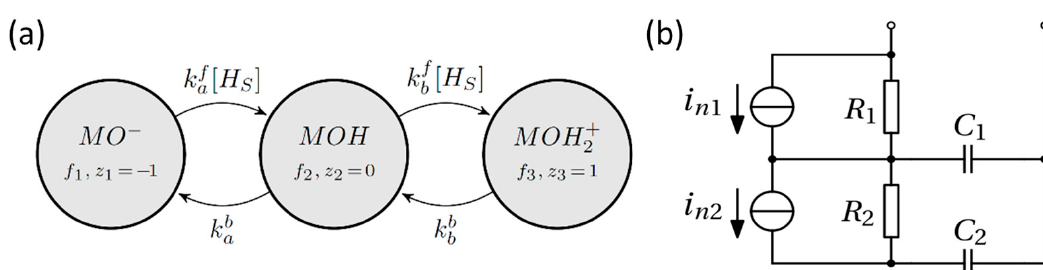
Figure 6. ( a ) Kinetic diagram of the site binding (SB) model from Reference [20]. The graph shows two chained reactions involving the protonation-deprotonation of one hydroxyl binding site. Each state is characterized by a net signed number of elementary charges, 𝑧 , and a probability of the site to be in that state, 𝑓 . The coefficients on the transitions arrows relate the probabilities of the two adjacent states. ( 𝑘 (cid:3028)(cid:3033) ; 𝑘 (cid:3028)(cid:3029) ) and ( 𝑘 (cid:3029)(cid:3033) ; 𝑘 (cid:3029)(cid:3029) ) are the forward and backward reaction constants for the first and second protonation reaction, respectively. ( b ) Equivalent noise circuit of the SB reactions in ( a ). The chemical noise is represented by the thermal noise of the resistors, here shown as Norton’s equivalent current generators.